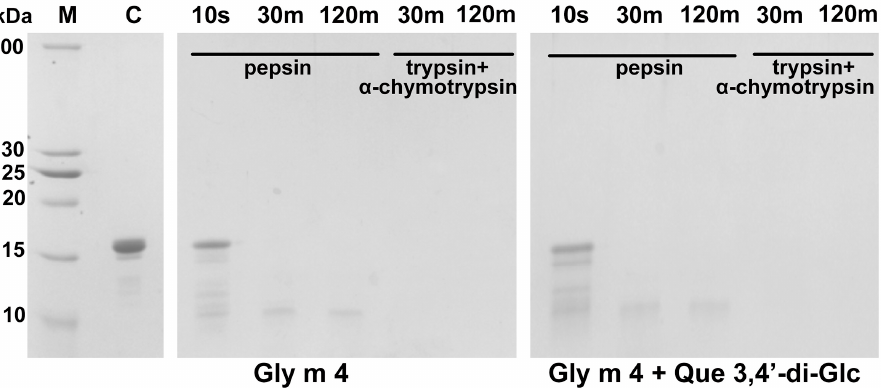
Figure 3. SDS-PAGE analysis of proteolytic cleavage mimicking gastrointestinal digestion in vitro of Gly m 4 with or without Que-3,4 (cid:48) -di-Glc. M—molecular mass standards; C—an intact Gly m 4 (control); 10 s, 30 m, 120 m—the allergen fragmentation after incubation with pepsin mimicking gastric digestion during 10 s, 30 min, 120 min, respectively, and digests after the subsequent allergen incubation with the mixture of trypsin and α -chymotrypsin during 30 min and 120 min,